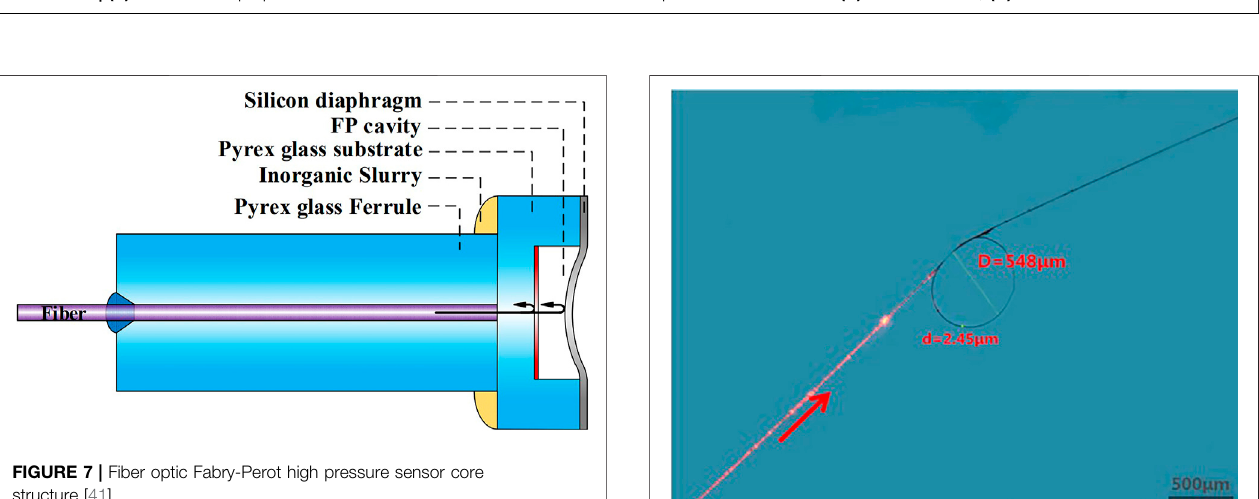
FIGURE 6 | (A) The microscope photo of the cross section of the cane and the SEM photos of the TC-PCF: (B) the whole fi ber; (C) holes section.